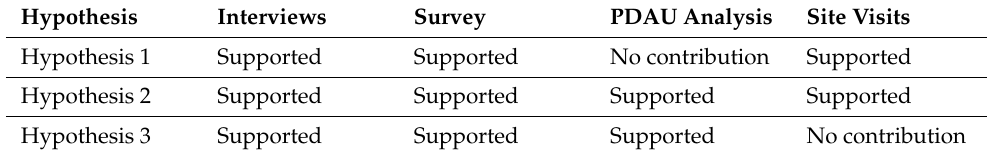
Table 5. Hypotheses supporting status according to study phases. Source: